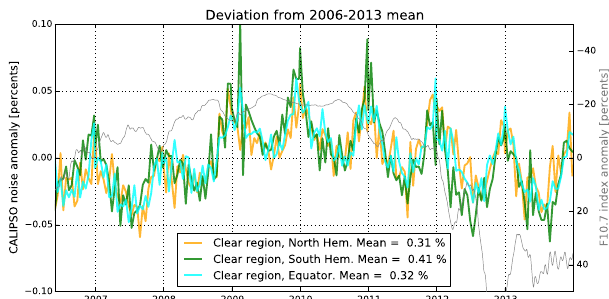
Figure 6. Same as Fig. 2, in areas supposedly unaffected by sources Fig. 6: Same as Fig. 2, in areas supposedly unaffected by sources of additional noise (orange, green and cyan boxes in Fig. 1). The grey line shows the deviation of the F10.7 of additional noise (orange, green and cyan boxes in Fig. 1). The index delayed by one year (as in Fig. 2) for reference. ! grey line shows the deviation of the F10.7 index delayed by 1 year (as in Fig. 2) for